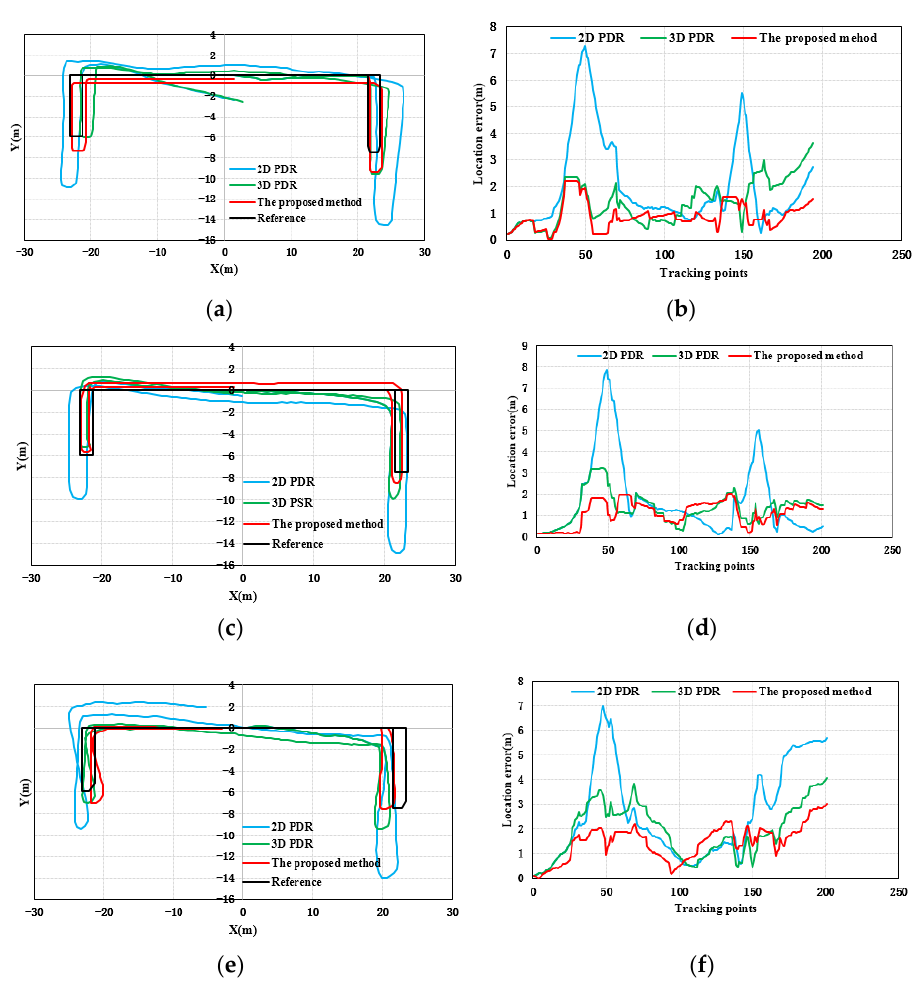
Figure 6. Distributions of location errors with respect to three participants, ( a , b ) participant 1, ( c , d ) participant 2, and ( e , f ) participant 3. Table 3. Statistical results of the RMSE of location results (m).